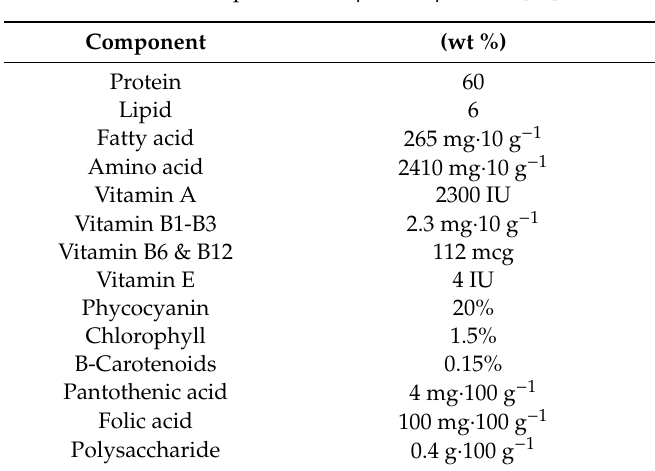
Table 2. Composition of Spirulina platensis